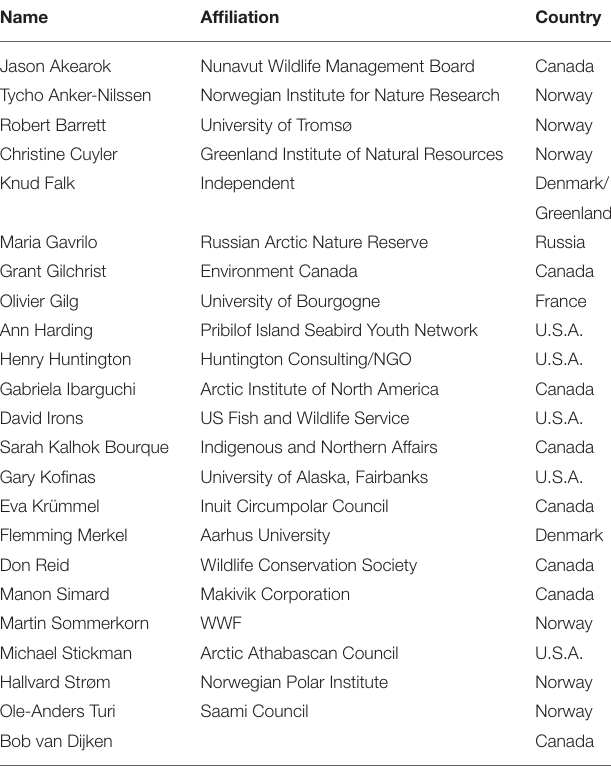
TABLE 1 | Summary of all participants interviewed on triage, with their affiliations (unless otherwise requested), and